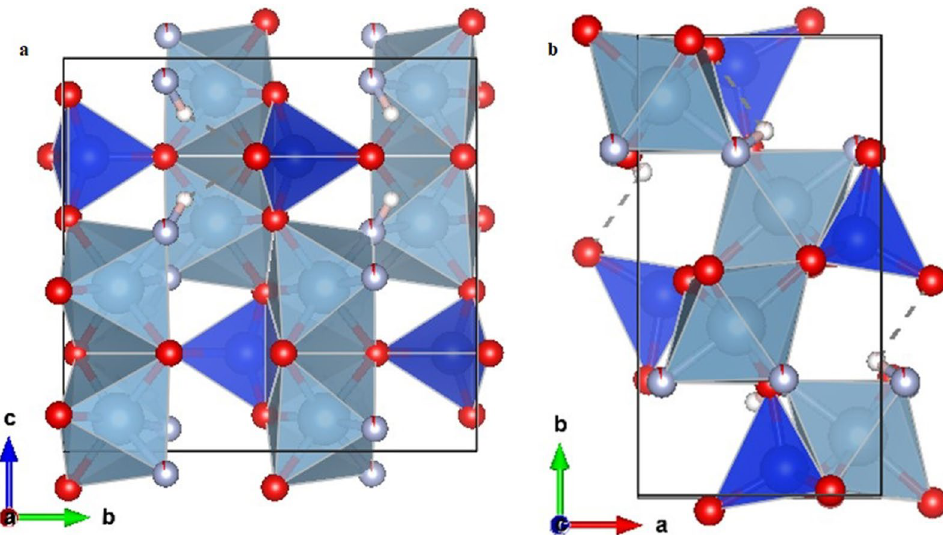
Figure 2. Projection of the topaz structure along the a ( a ) and c axes ( b ), respectively. The tetrahedral [SiO 4 ] 4− groups, in blue, are linked to octahedral chains of Al[O 4 (F,OH) 2 ], in grey, in a zig zag fashion parallel to the c -axis. The smaller red, grey and white atoms are O, F and H, respectively. The structure image has been obtained using VESTA Version 3 (https ://jp-miner als.org/vesta /en/downl